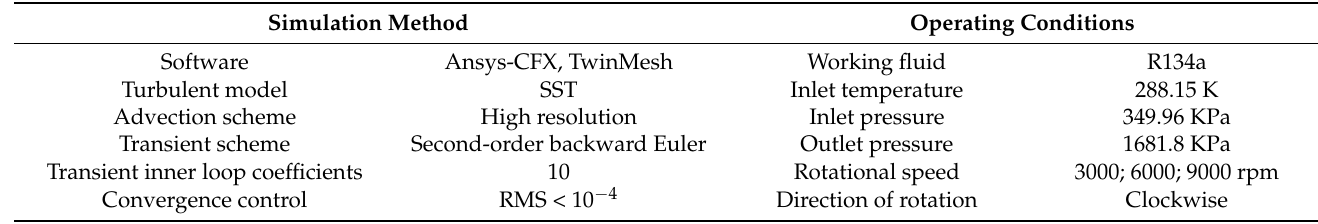
Table 2. Simulation method and operational